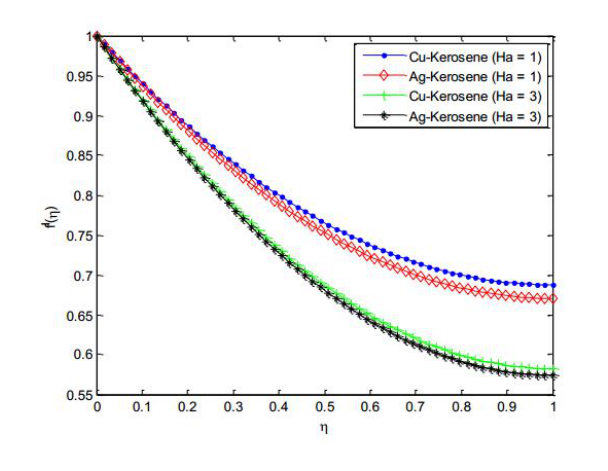
Figure 6. Effect of Magnetic field parameter (Hartmann number) on the fluid velocity distribution